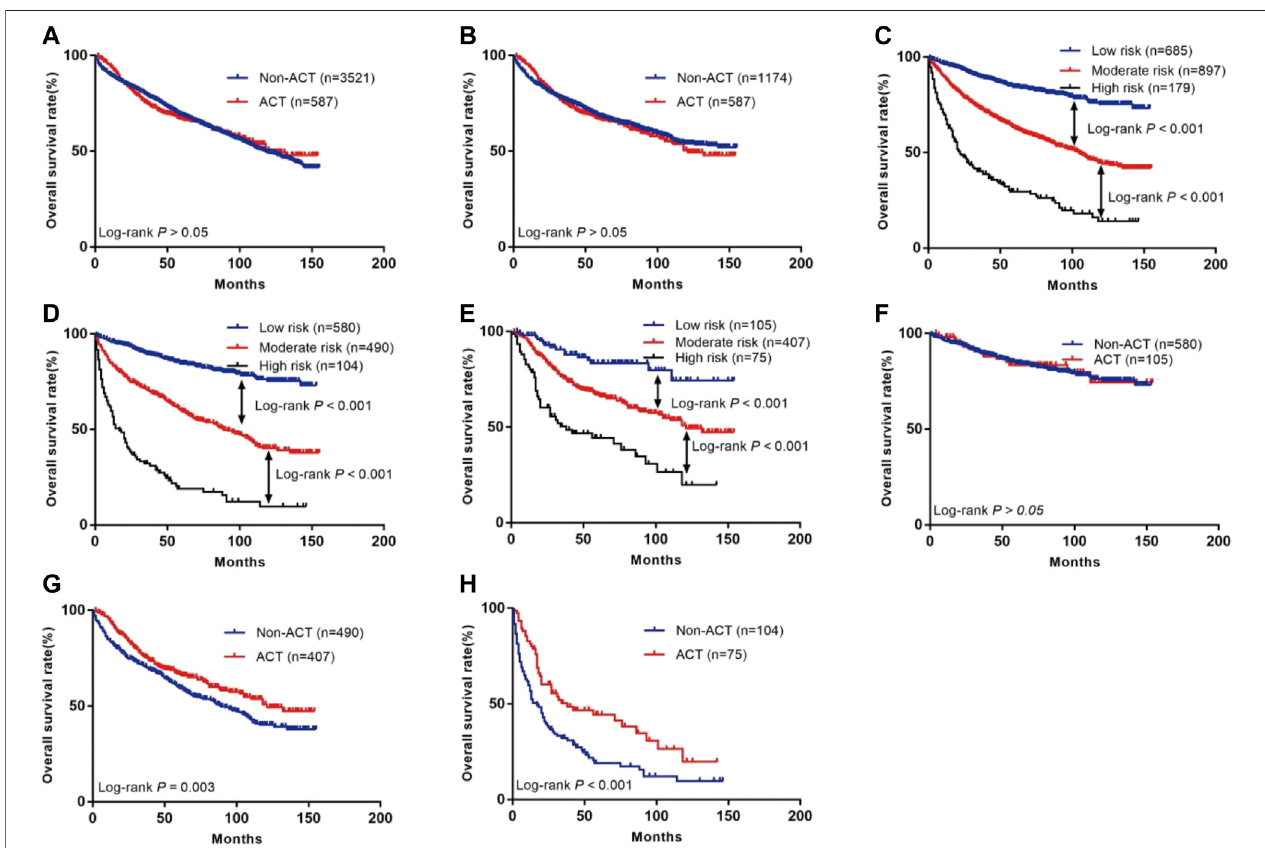
FIGURE 2| The Kaplan-Meier curves ofOS for patients in our study. (A) All patients; (B) Patients after PSM; (C) OS in low, moderate and high risksubsets ofnon- ACT group and ACT group; (D) OS in different subsets of non-ACT group; (E) OS in different subsets of ACT group; (F) OS for patients with or without ACT in low risk group; (G) OS for patients with or without ACT in moderate risk group; (H) OS for patients with or without ACT in high risk group.